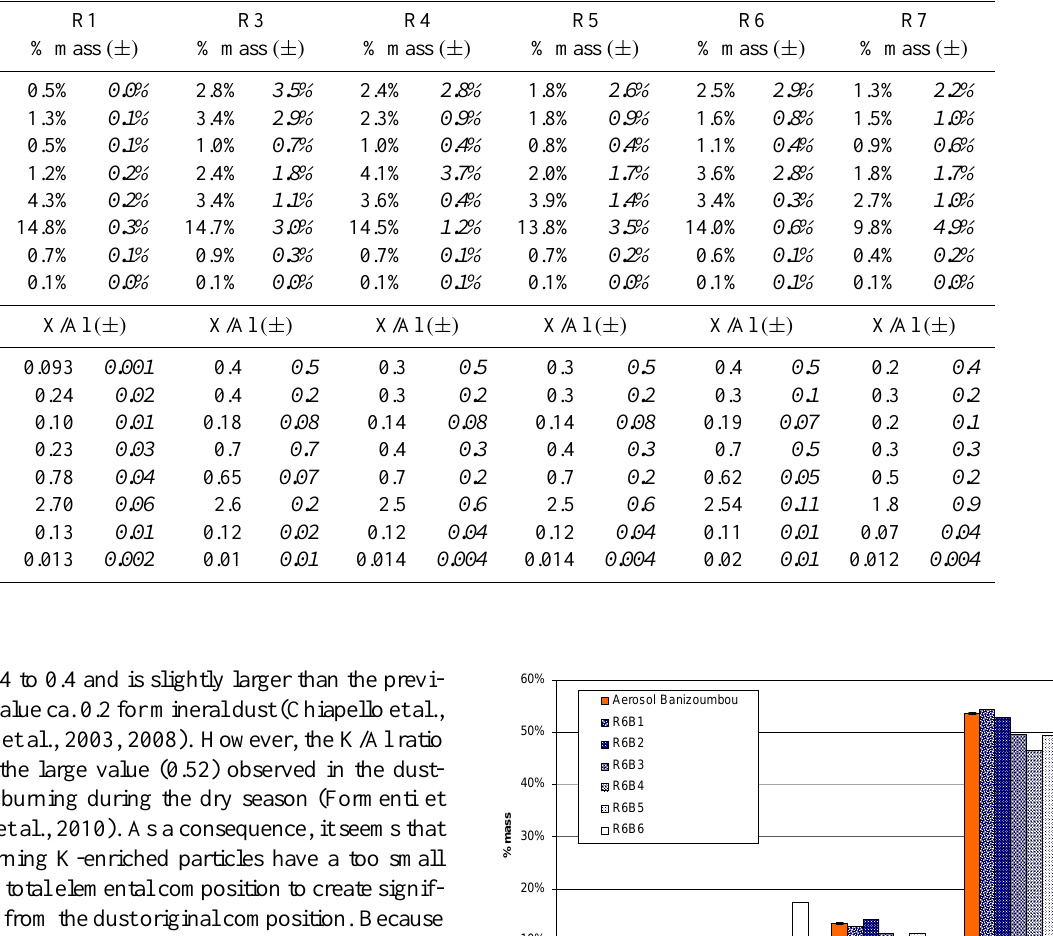
Table 2. Mean elemental total composition and mean elemental Al ratio for the samples not influenced by local dust wash-out.